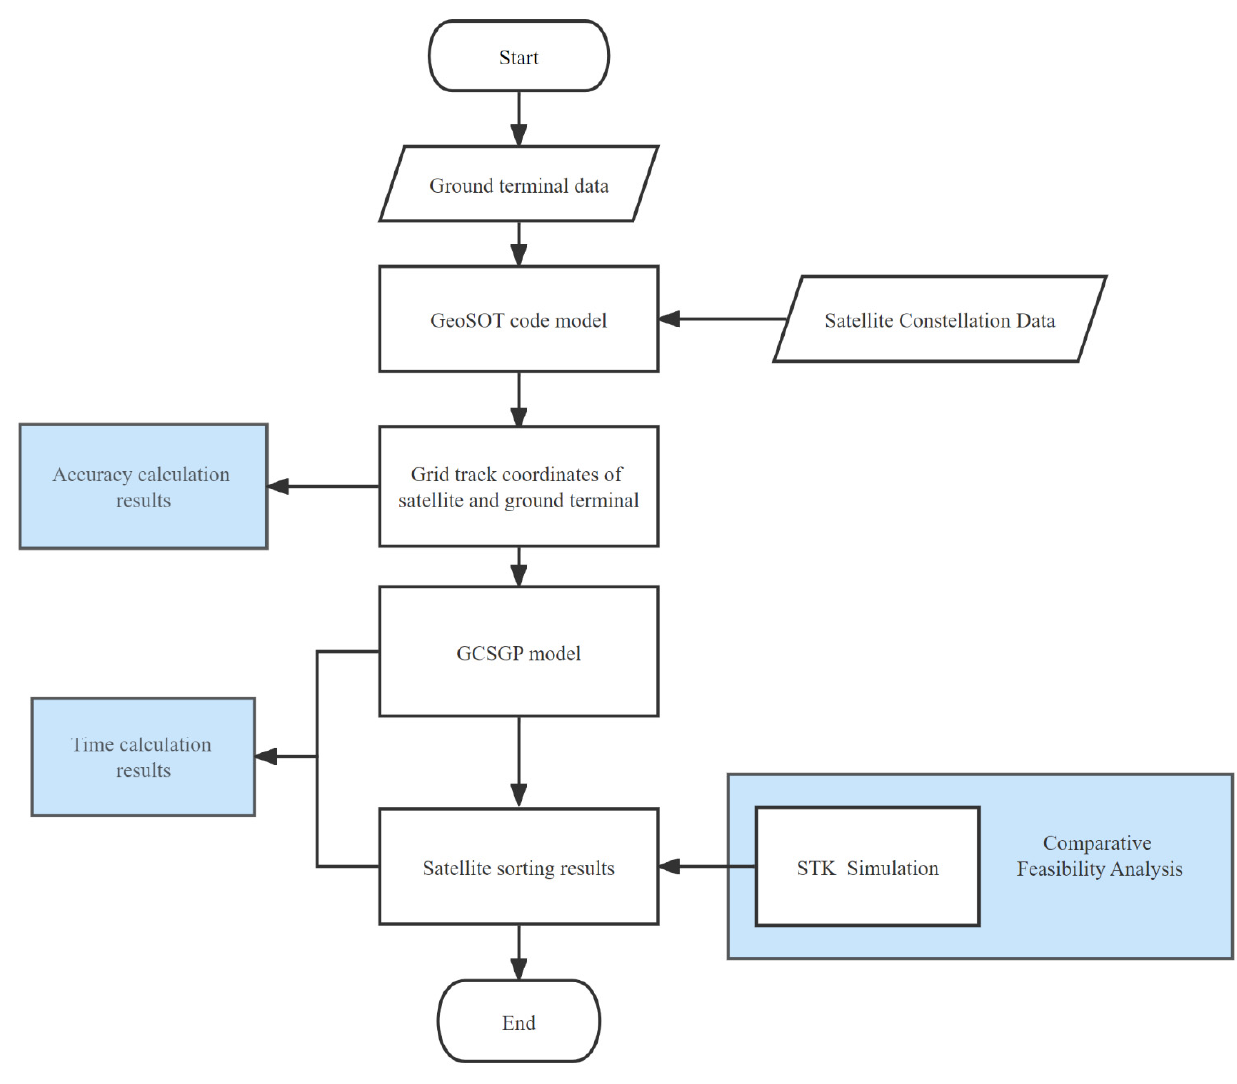
Figure 7. Experimental flow chart. Table 1. Satellite data for